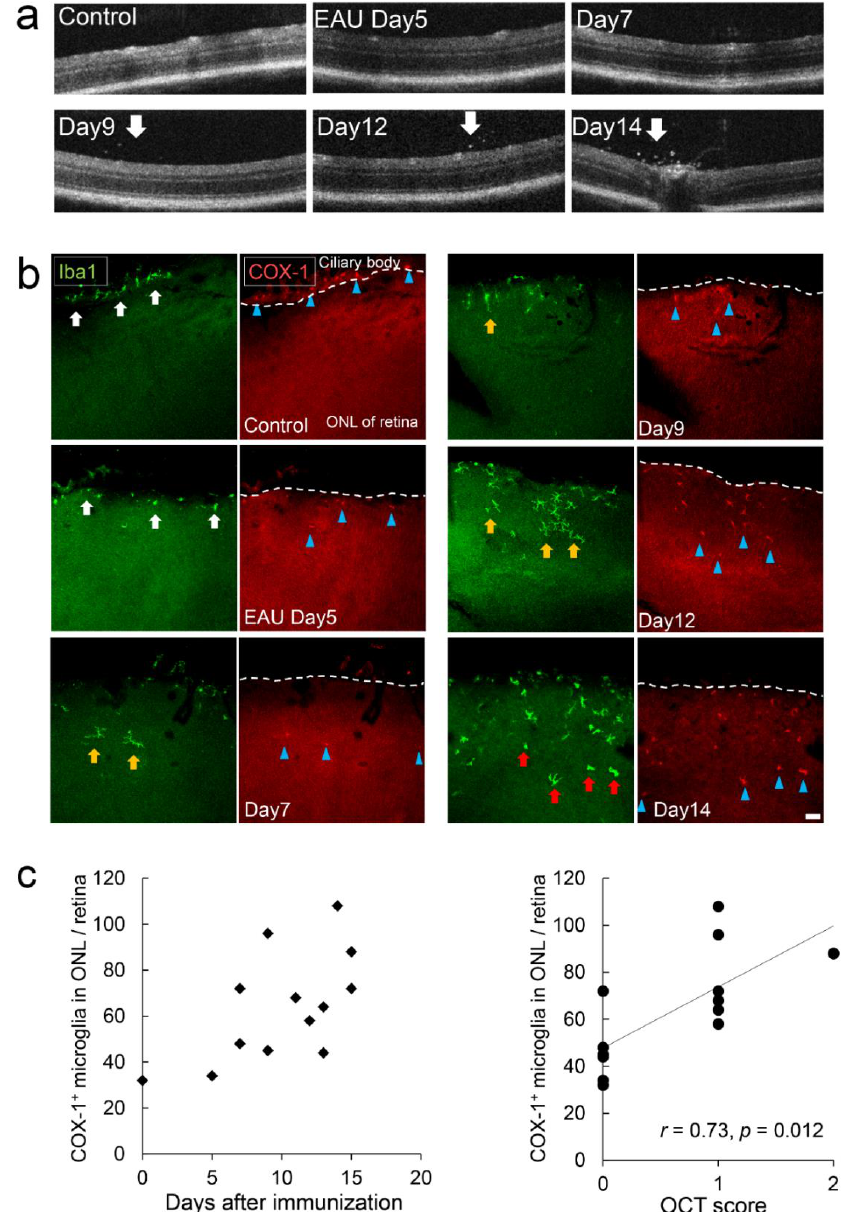
Figure 7. COX-1 + microglia/macrophage dynamics in early phase of the experimental autoimmune uveoretinitis (EAU) model. Mice were immunized with IRBP peptide to develop autoimmune uveoretinitis. ( a ) OCT imaging showed cell infiltration into the vitreous (white arrows). Day, the day after immunization. ( b ) Photomicrographs of the flat-mounted retina of EAU mice labeled with Iba1 (left) and COX-1 (right). All COX-1 + cells found in the ONL were Iba1 + cells. They first had a small cell body and thin processes (white arrows) which became thicker (yellow arrows) and, finally, changed into amoeboid forms (red arrows). Iba1 + COX-1 + cells gradually increased in the ONL of the retina, from the ciliary body side to the center of the retina. Dashed lines show the boundary between the ciliary body and the retina. On days 5, 7, 9, 12, and 14, Iba1 + COX-1 + cells were found as far as 114, 207, 107, 236, and 336 μm from the border to the choroid, respectively (blue arrowheads). Scale bar, 50 μm. ( c ) COX-1 + cells infiltrating into the ONL increased with time after immunization. The number of COX-1 + cells infiltrating into the ONL correlated with the OCT score. Spearman ( n = 13, r = 0.73, p = 0.012).